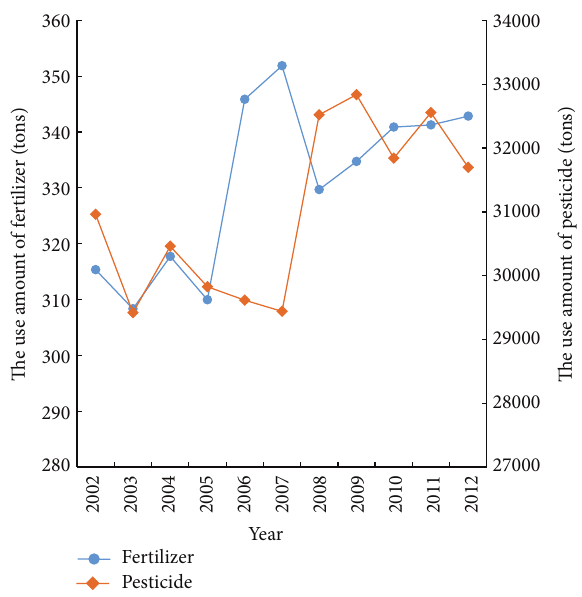
Figure 6: The amount changes of fertilizer and pesticide in the Nansi Lake Basin during 2002 to